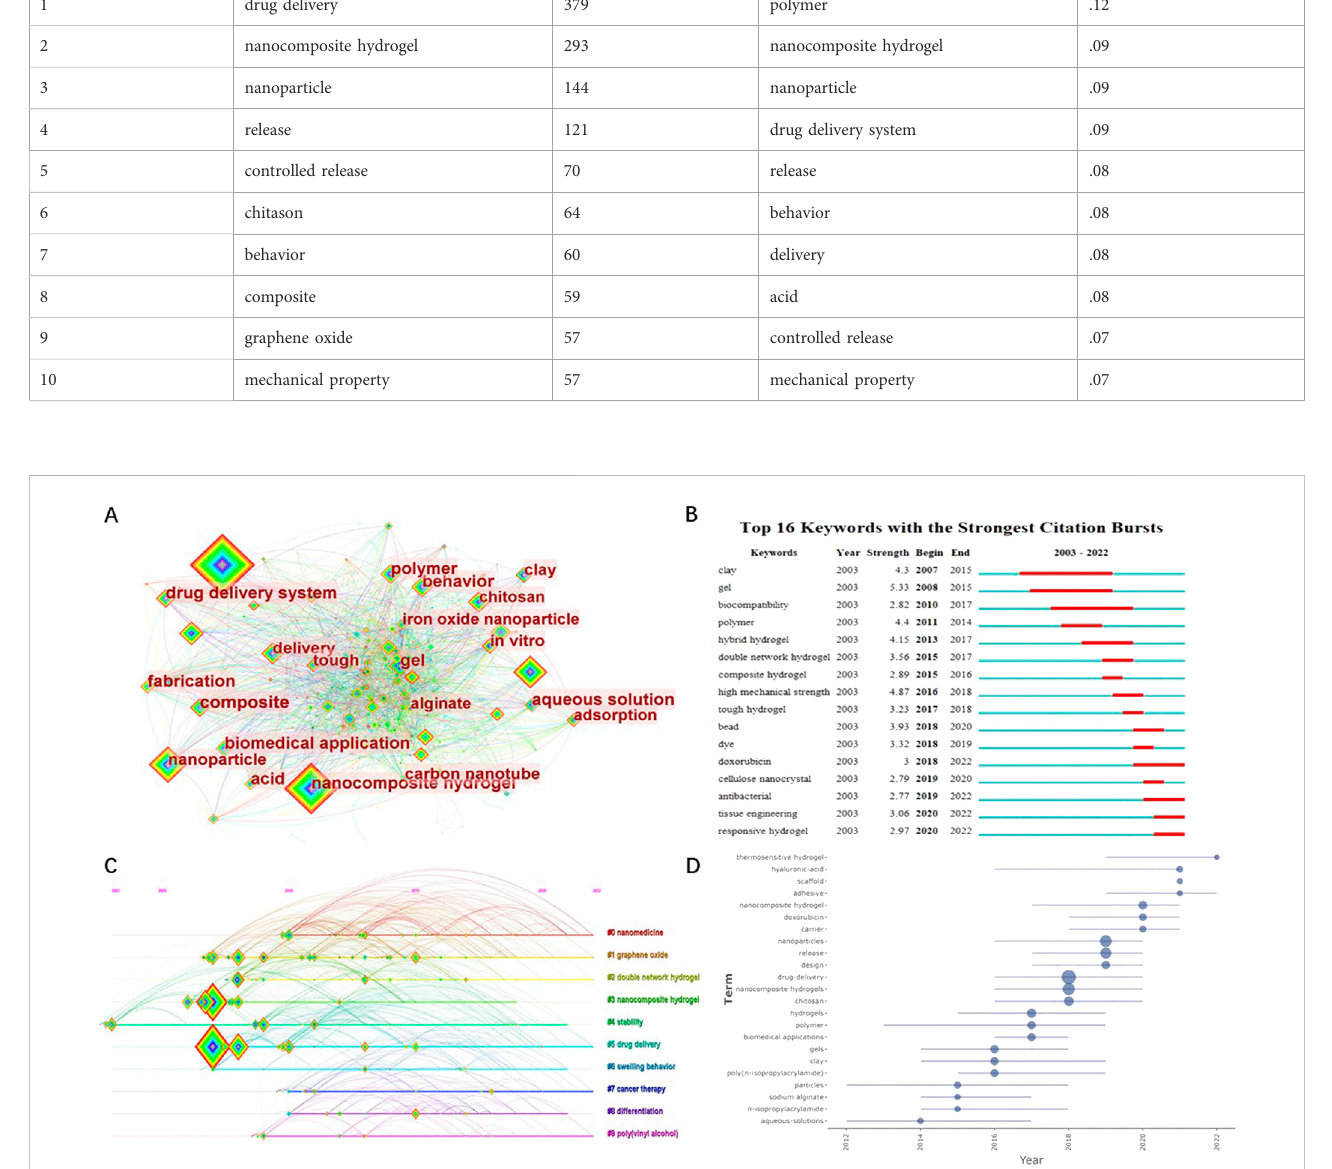
FIGURE 7 Visualized analysis of keywords regarding the publications on the applications of NHs for drug delivery. (A) The keywords co-occurrence network; (B) Keywords burst analysis indicated by the map of “ Top 16 Keywords with the Strongest Citation Bursts ” ; (C) The timeline of clustering for keywords; (D) Map